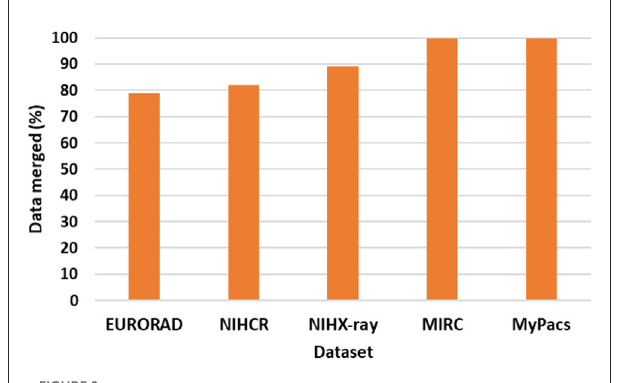
FIGURE9 Super-category merge